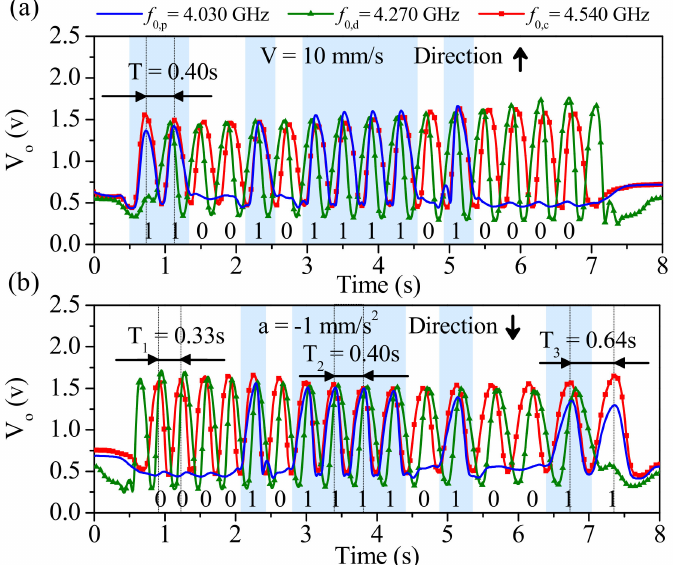
Figure 27. Measured envelope functions for ( a ) encoder motion up and v = 10 mm/s; ( b ) encoder motion down with constant acceleration of a = − 1 mm/s 2 . The considered vertical distance, or air gap, between the encoder and the reader is 1 mm in both cases. Reprinted with permission from [28]. Copyright 2020